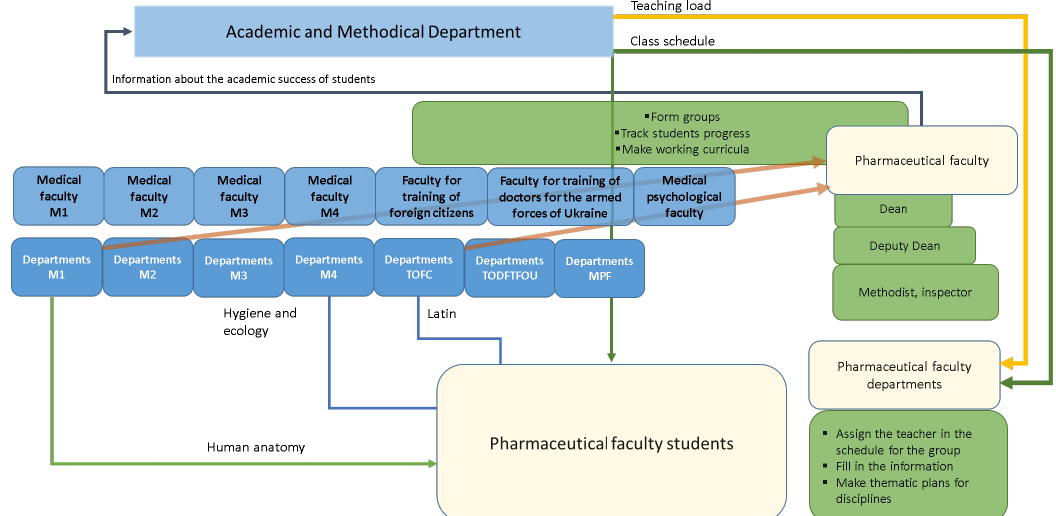
Figure 2: Scheme of interaction of the educational and methodical department with the faculties of the